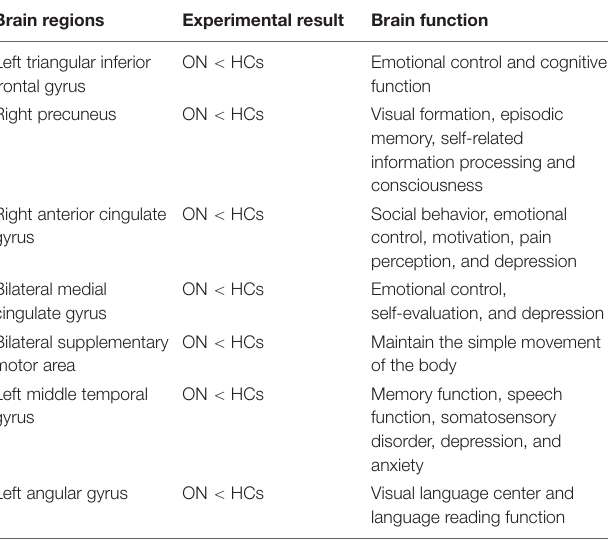
TABLE 5 | Brain regions alternation and its potential